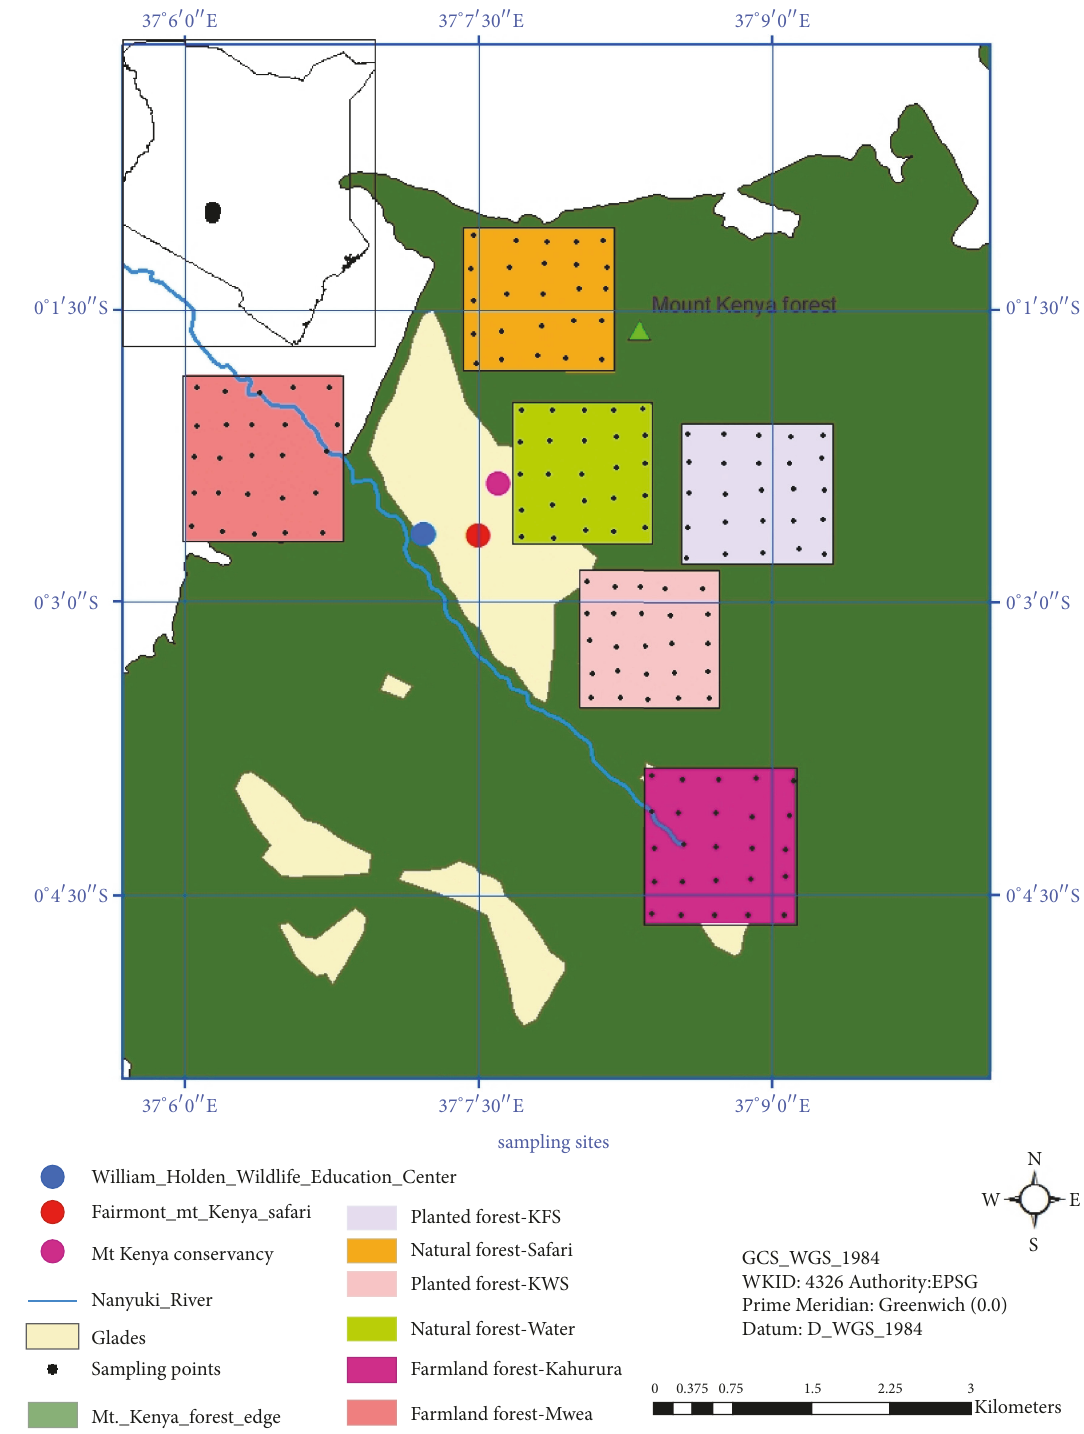
Figure 1: Study area map. Bird point counts marked using coloured